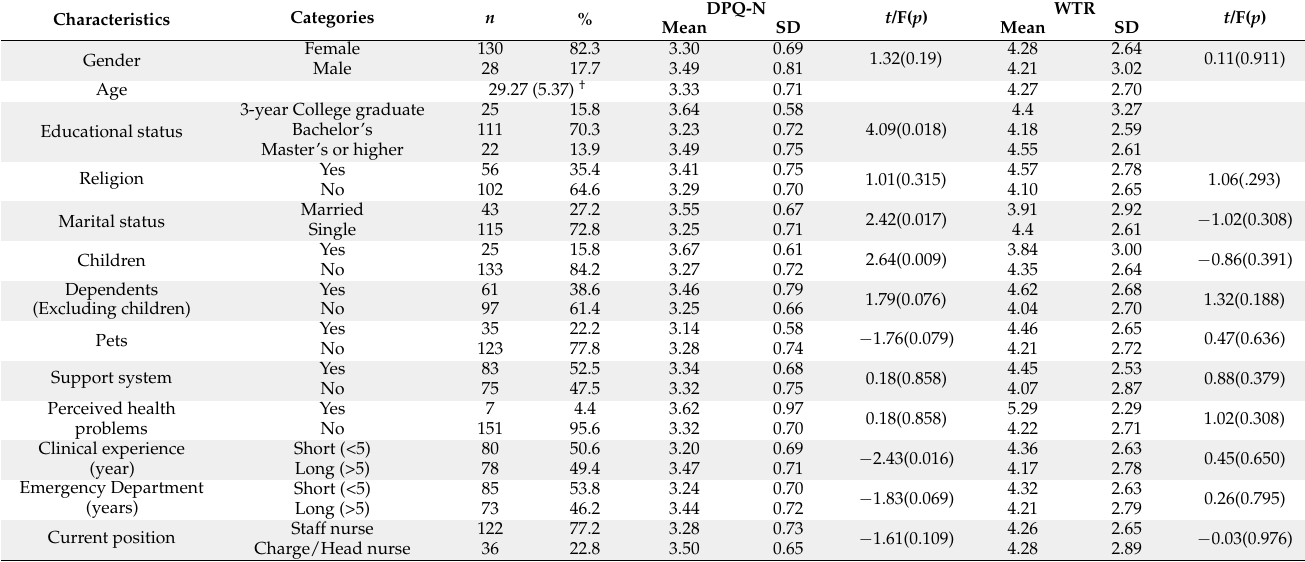
Table 1. Differences in disaster preparedness and WTR by demographic characteristics ( N = 158).